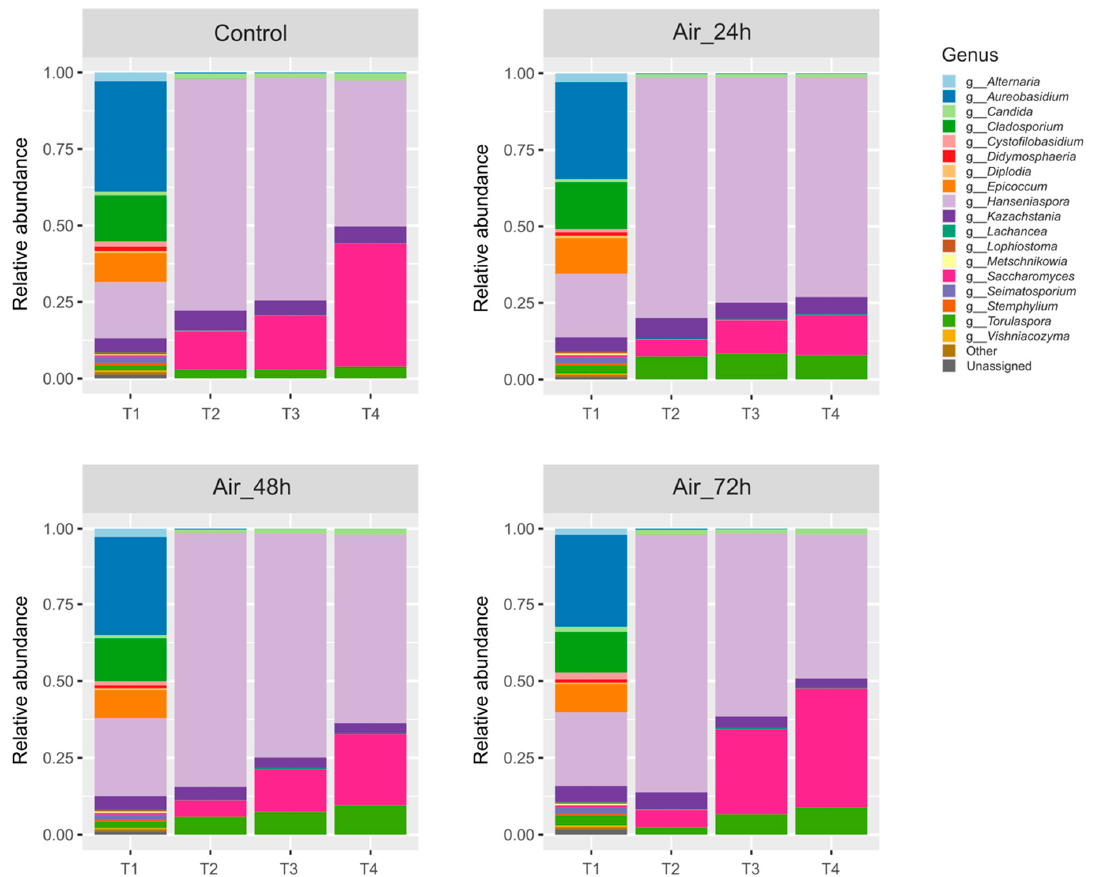
Figure 2. Genus-level metabarcoding analysis of community response to aeration given at 24 h, 48 h and 72 h post-crushing of grapes in the 2019 vintage. Ferment samples were taken at four time points: T1, 0%; T2, 20%; T3, 50%; T4, 80% of sugar consumption. All sub-columns show mean percentages of three